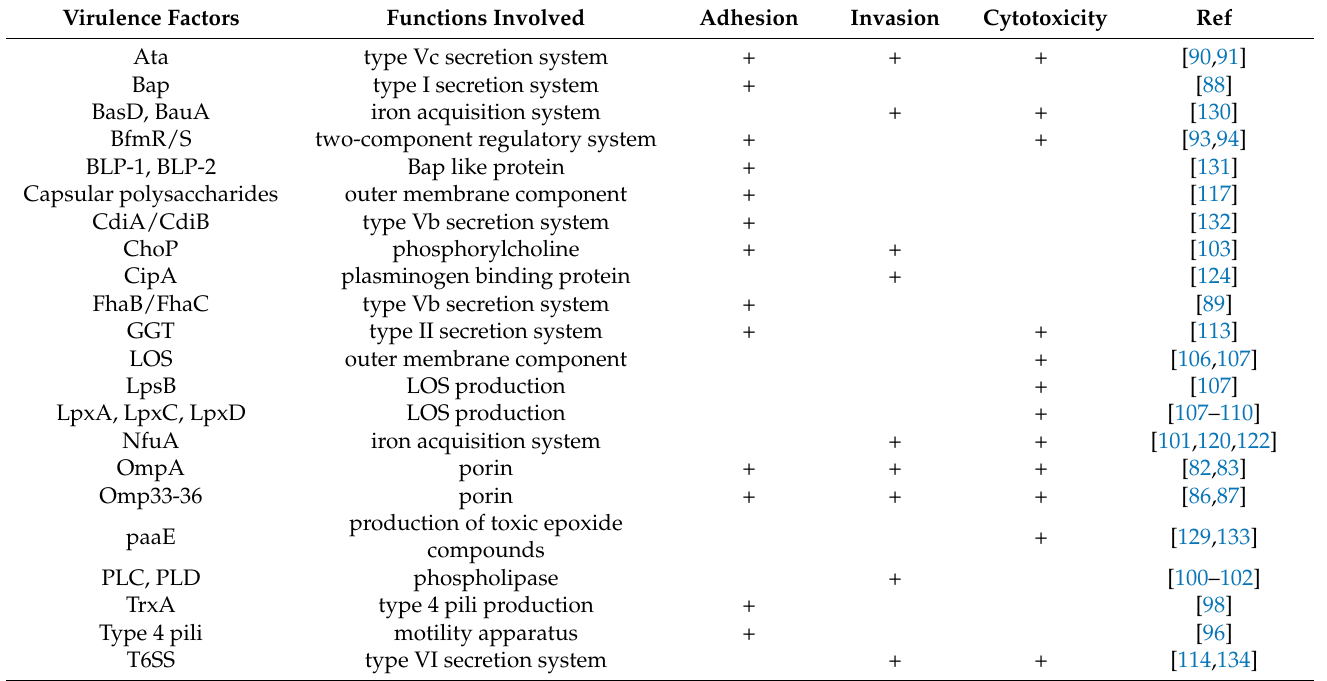
Table 1. Identified A. baumannii Virulence Factors and Associated